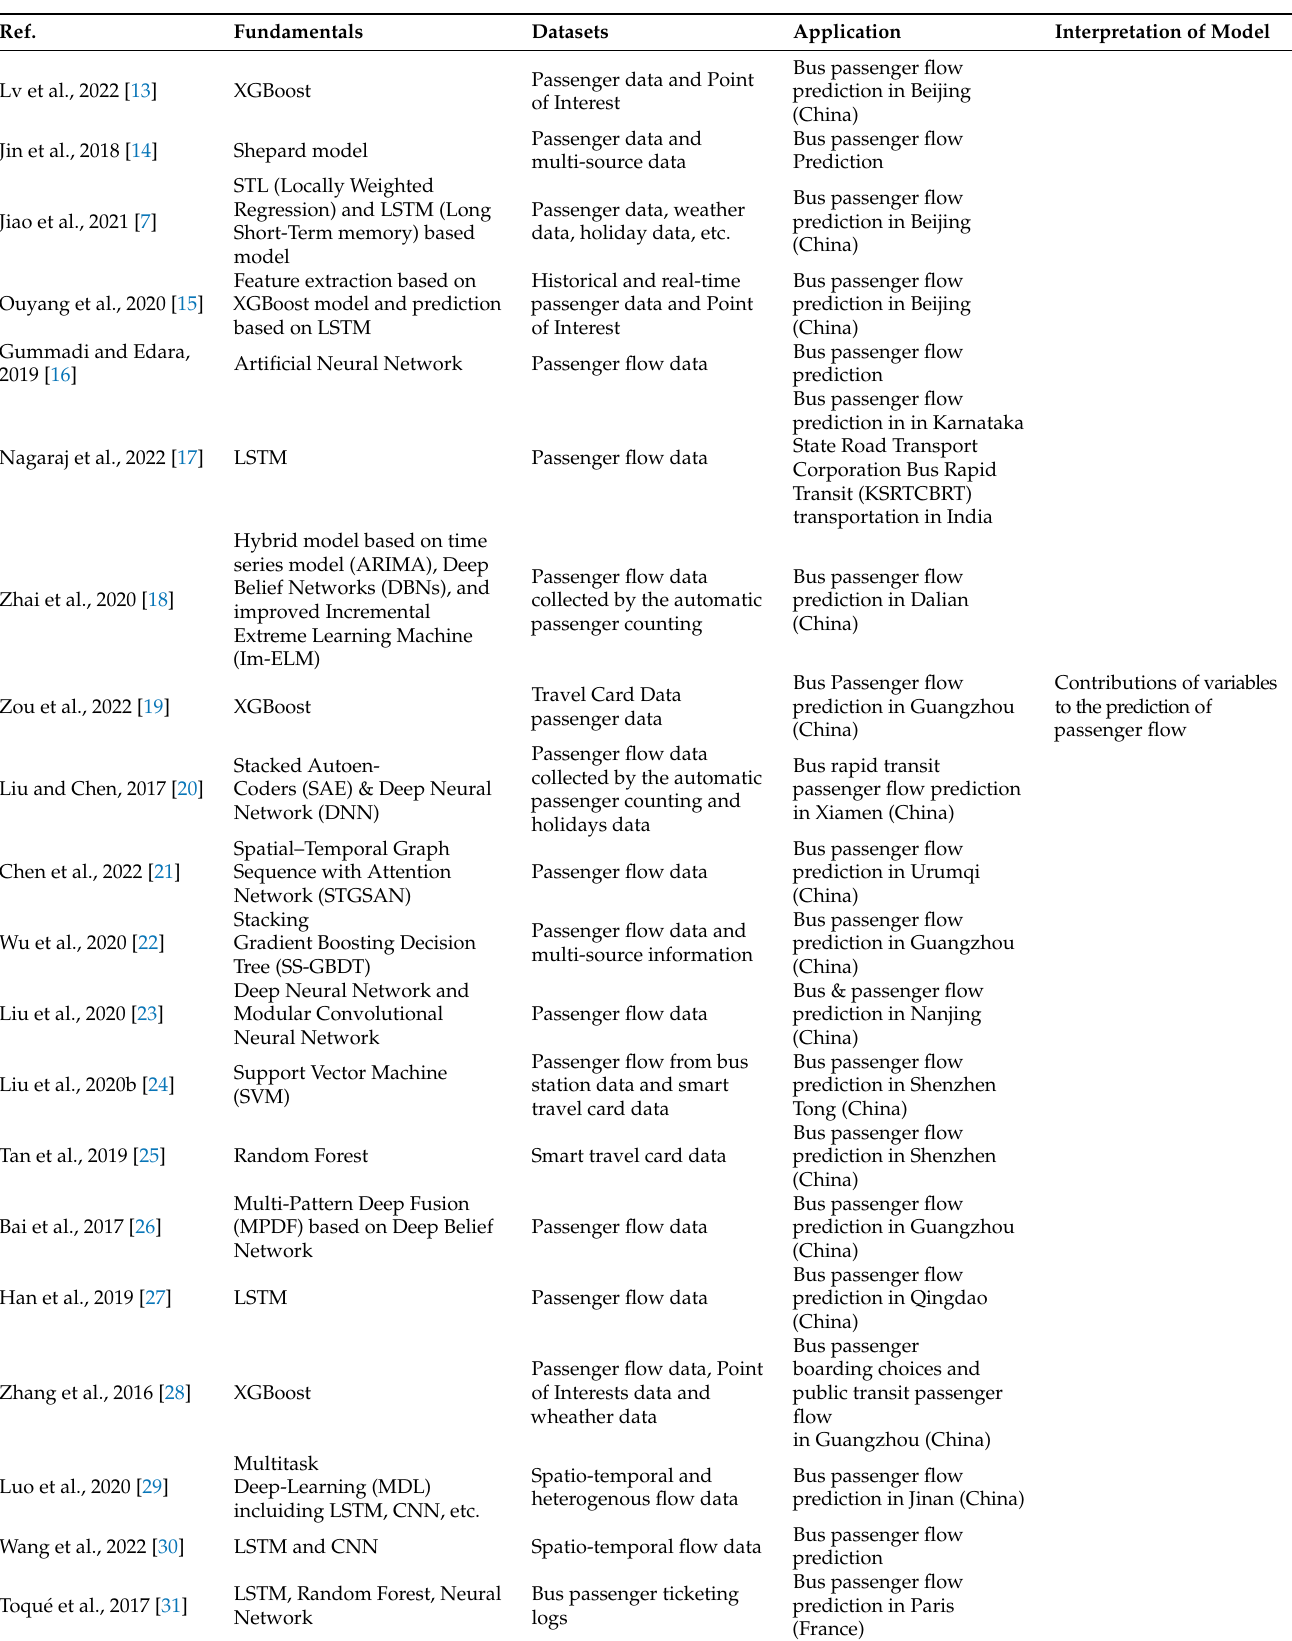
Table 1. Bus passenger flow prediction related